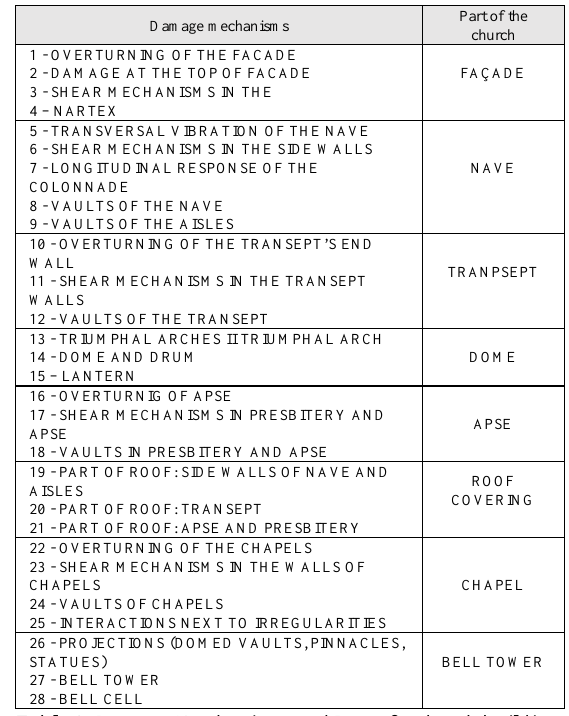
Table 2. Damage Mechanisms and Part of a church